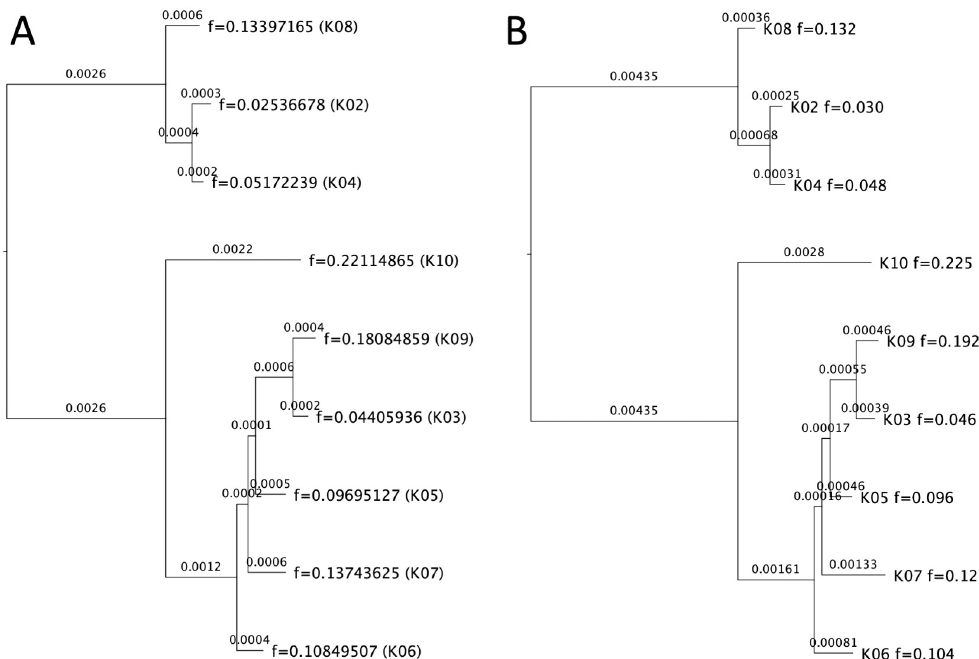
Fig 7. Result on a real data set with mixture of 9 sub-samples. The haplotype K01 was removed from the mixture and the experiment was repeated. (A) The tree with tip relative abundances reported by AFPhyloMix. (B) The tree reported by IQ-TREE [26]. Note that the tip labels inside the brackets in (A) were added manually after comparing with the tree reported by IQ-Tree, indicating the corresponding sample that each tip should be assigned to according to the topology and the tip relative